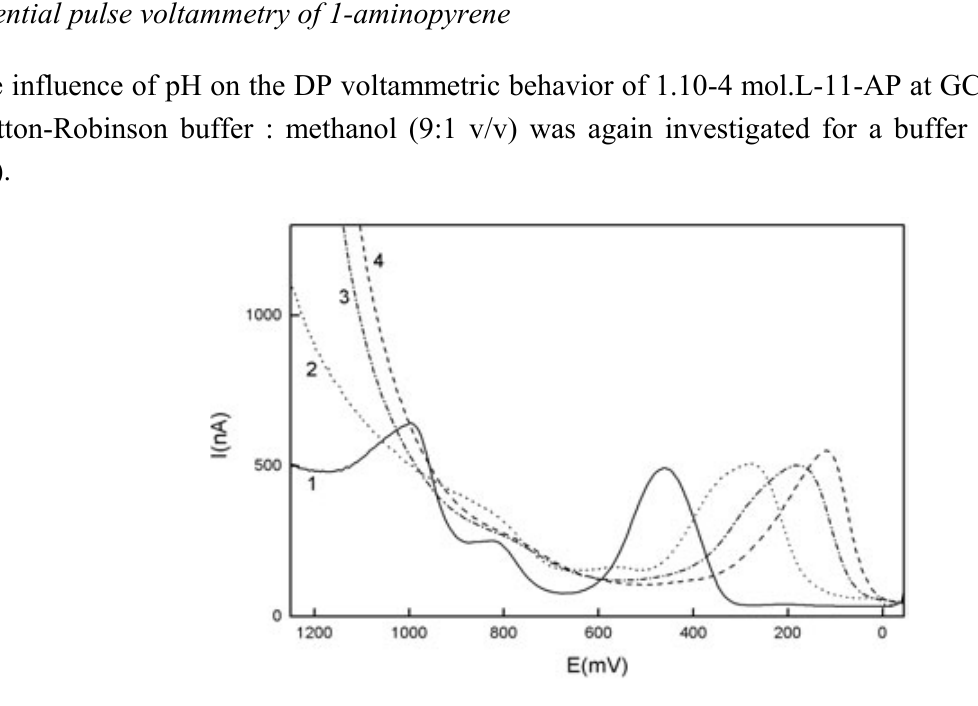
Figure 2. Selected DP voltammograms of 1-AP (c=1.10 -4 mol.L -1 ) at GCPE in a mixture of BR buffer : MeOH (9:1) at buffer pH 2(1), 6 (2), (3) 10, 12